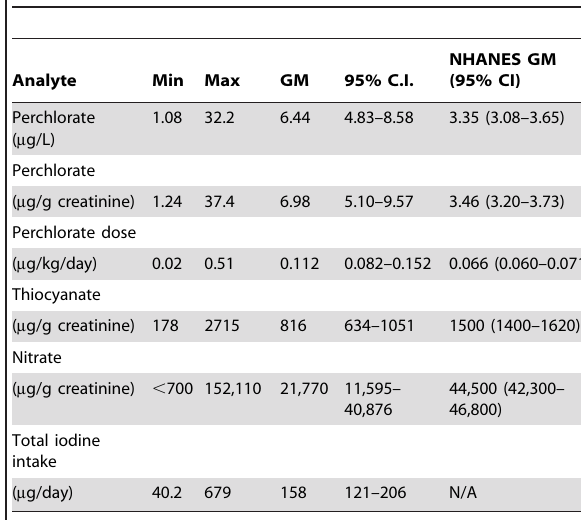
Table 3. Range and Geometric Means of Major